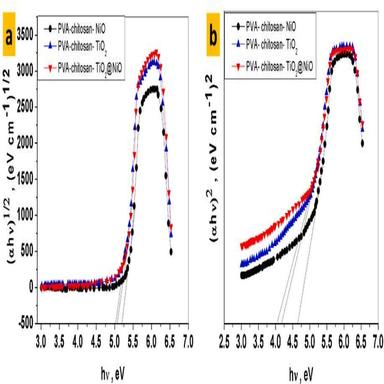
Plots of (a) (αhν) 2 versus hν and (b) (αhν) 1/2 versus hν for PVA-chitosan–TiO2, PVA-chitosan–NiO, and PVA-chitosan–TiO2@NiO films.